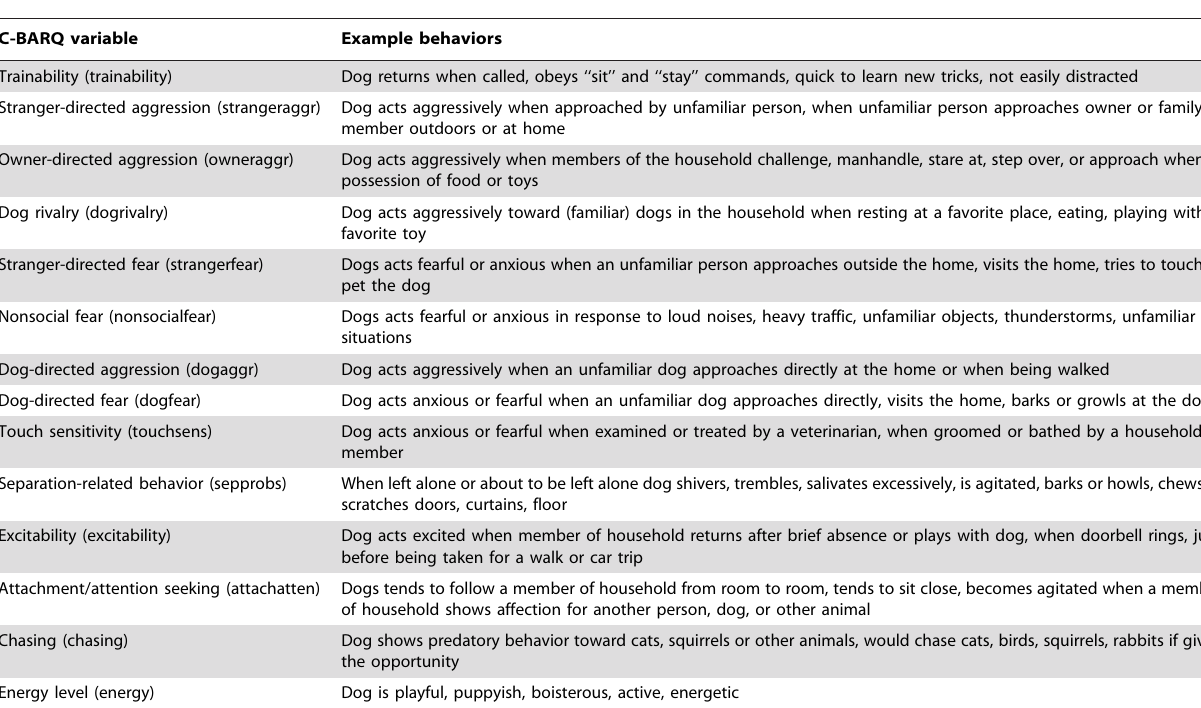
Table 1. Brief description of C-BARQ behavior and temperament scales (see [10,12] for